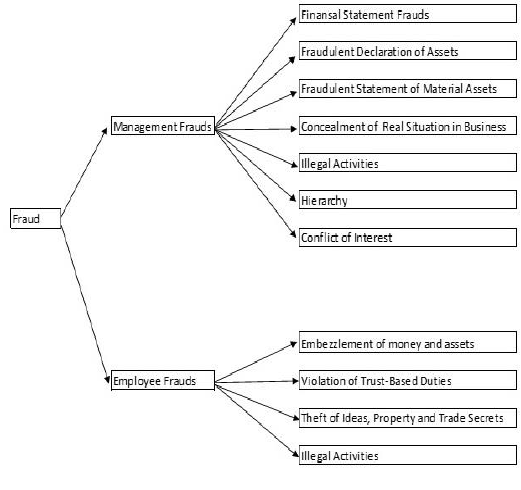
Figure 1. Types of Fraud